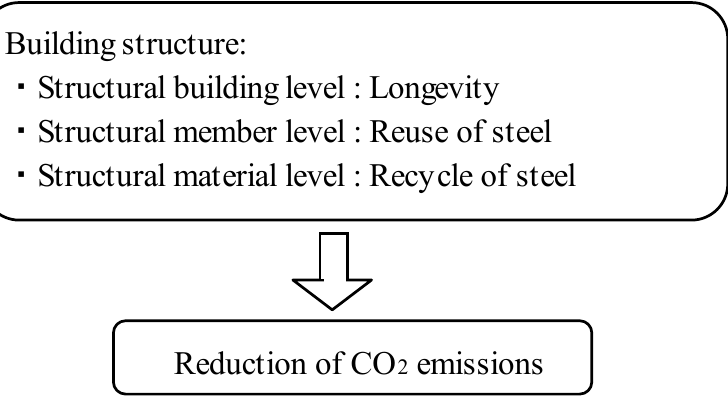
Figure 1. Environmental performance and building